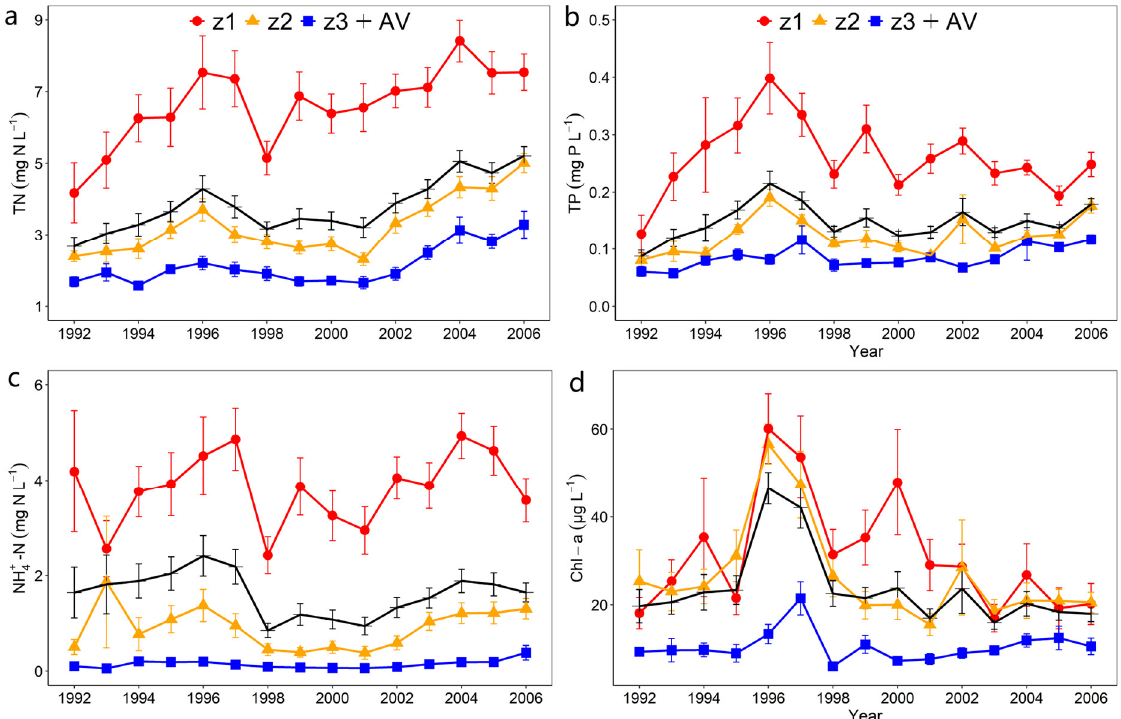
Figure 3. Annual concentrations (mean ± SE) of ( a ) TN, ( b ) TP, ( c ) NH 4 + –N, and ( d ) Chl–a concentrations from 1992 to 2006 in different zones. AV denotes the total average value of the eight sites.